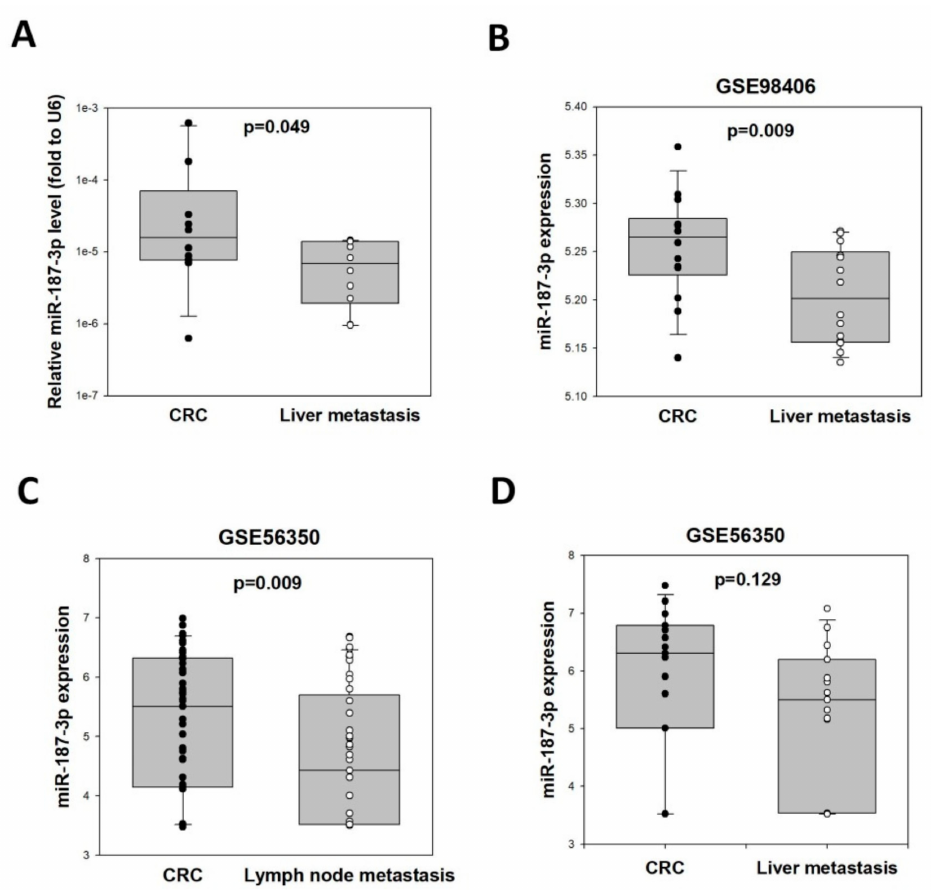
Figure 5. MiR-187-3p levels were lower in metastatic cancer cells compared to primary CRC cells: ( A ) MiR-187-3p levels in paired liver metastasis and primary CRC specimens of 10 patients in this study. ( B ) Data obtained from the GEO dataset GSE98406 showing that miR-187-3p levels were significantly lower in liver metastases comparing to primary CRC cells ( n = 14). ( C ) Data obtained from the GEO dataset GSE56350 showing that miR-187-3p levels were significantly lower in lymph node metastases compared to primary CRC cells ( n = 41). ( D ) Data obtained from the GEO dataset GSE56350 showing that there was a trend of lower miR-187-3p levels in paired liver metastases comparing to primary CRC cells ( n = 14). · and indicated the individual data points of adjacent (cid:35) normal tissues and CRC,